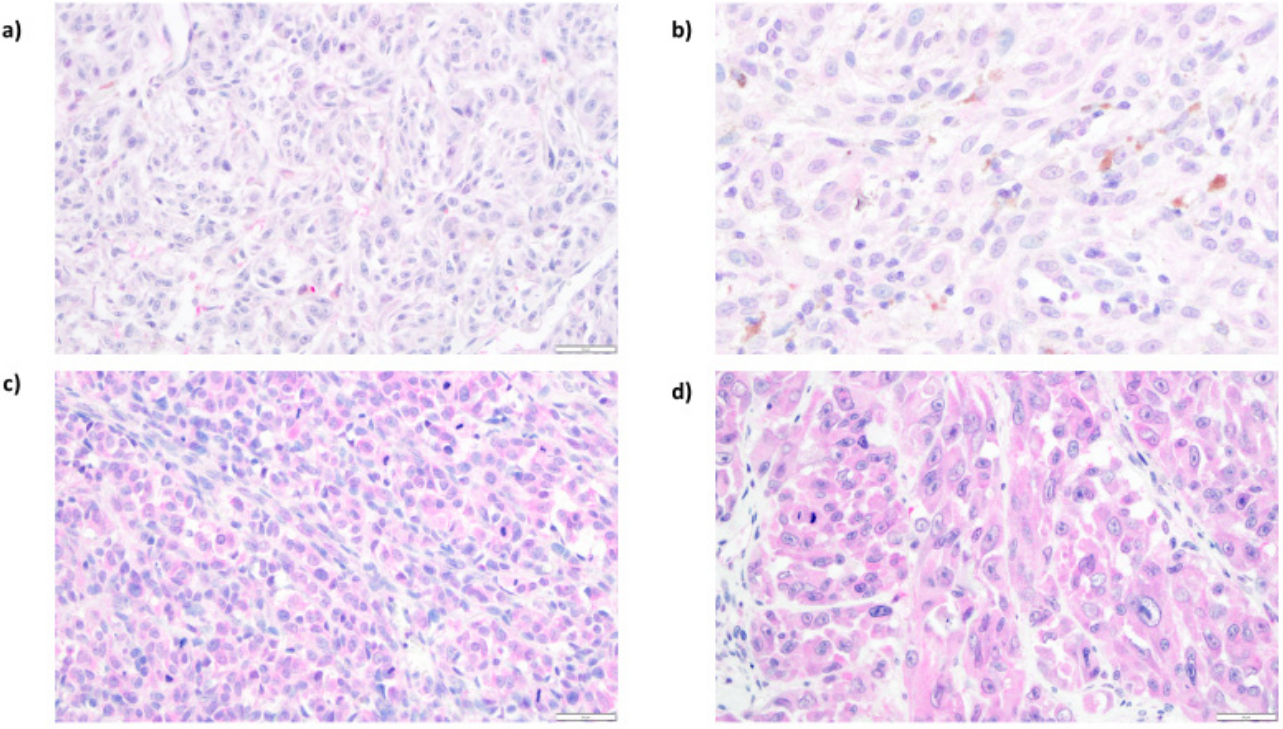
Figure 4. Representative results of immunohistochemical analysis of ENO1 expression in cutaneous melanoma patients. Low cytoplasmic ENO1 immunoreactivity in melanoma cells (( a ), 200×; ( b ), 400×). High expression of ENO1 in tumoral cells (( c ), 200×; ( d ), 400×).